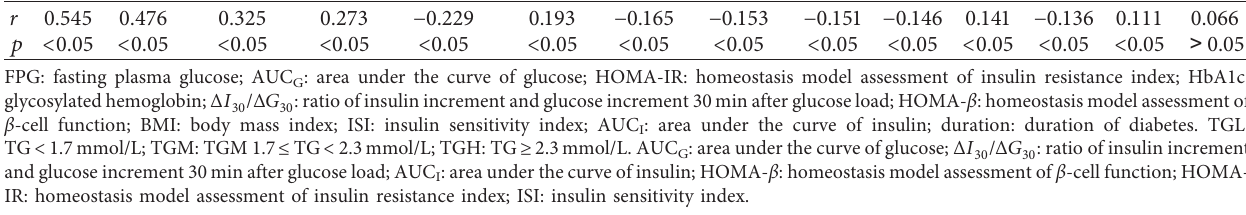
Table 2: Correlation analysis between glucagon and related parameters.